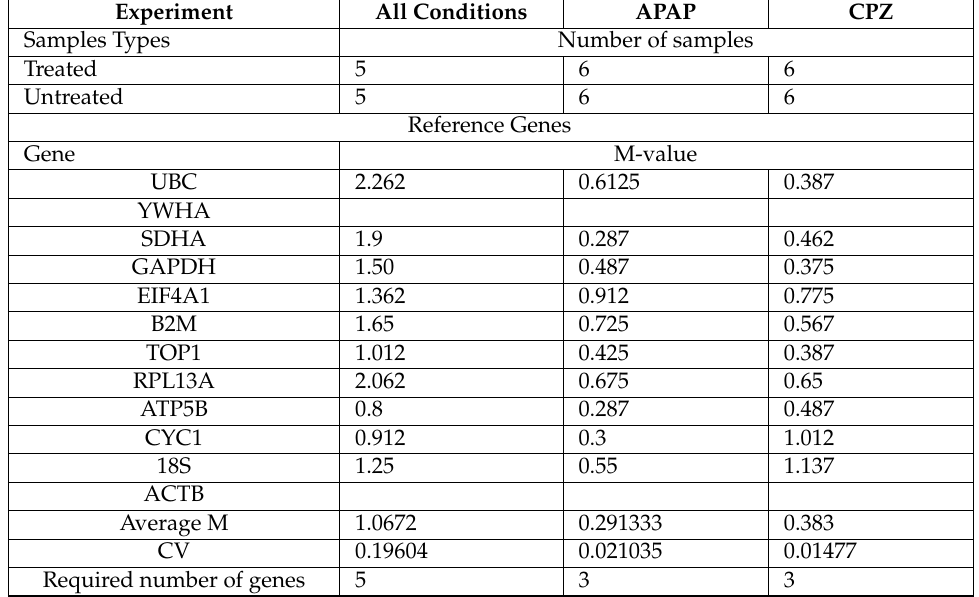
Table 3. Stability values per gene in various experimental